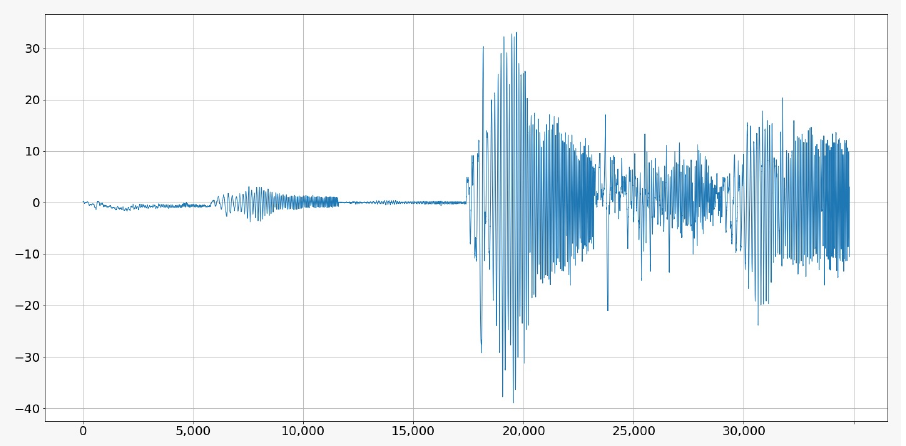
Figure 5. Tensor reduction of a sensor time